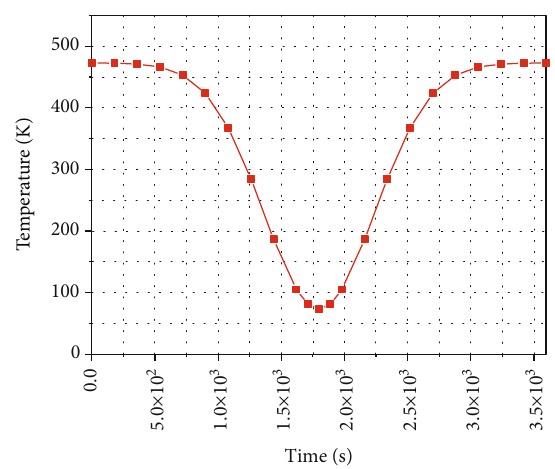
Figure 5: Temperature distribution of the transient temperature fi